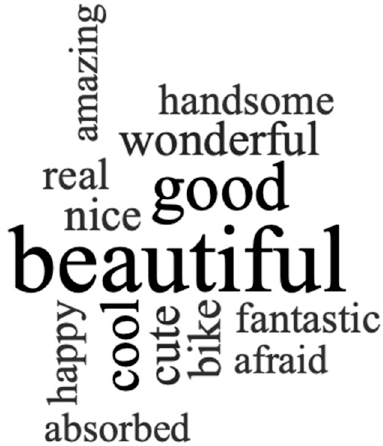
Figure 4. Word frequency of participants’ opinion on the experiment.